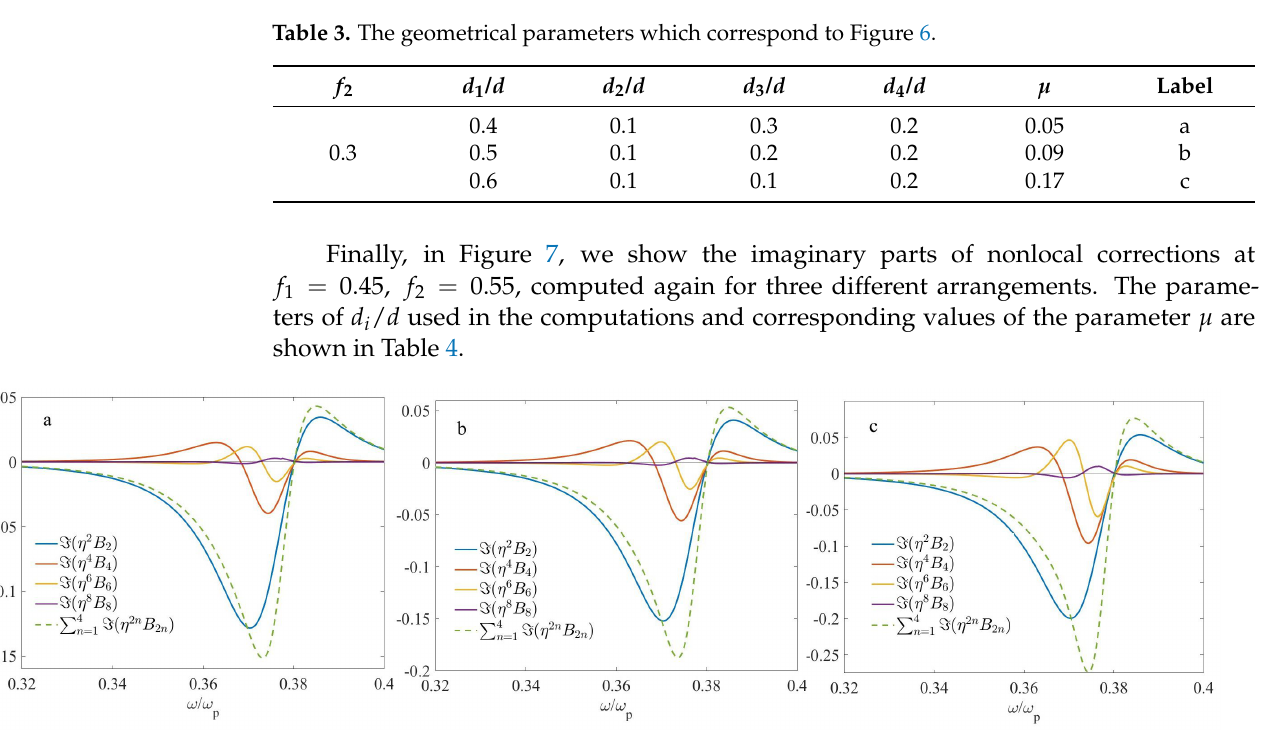
Figure 7. The frequency dependencies of the imaginary part of nonlocal corrections to the effective per- mittivity at f 1 = 0.45, f 2 = 0.55: ( a ) d 1 / d = 0.2, d 2 / d = 0.3, d 3 / d = 0.25, d 4 / d = 0.25, ( b ) d 1 / d = 0.2, d 2 / d = 0.35, d 3 / d = 0.25, d 4 / d = 0.2, and ( c ) d 1 / d = 0.2, d 2 / d = 0.4, d 3 / d = 0.25, d 4 / d = 0.15. Table 4. The geometrical parameters that correspond to Figure